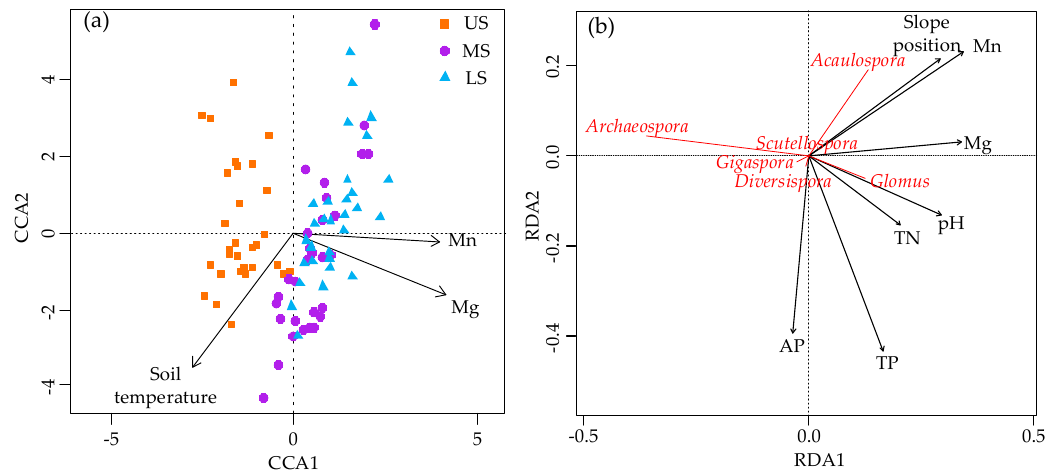
Figure 8. Canonical correspondence analysis (CCA) ordinations of dissimilarities of ( a ) OTUs’ relative abundance among samples with edaphic factors and redundancy analysis (RDA) ordinations of dissimilarities of ( b ) AMF genera with environmental factors.